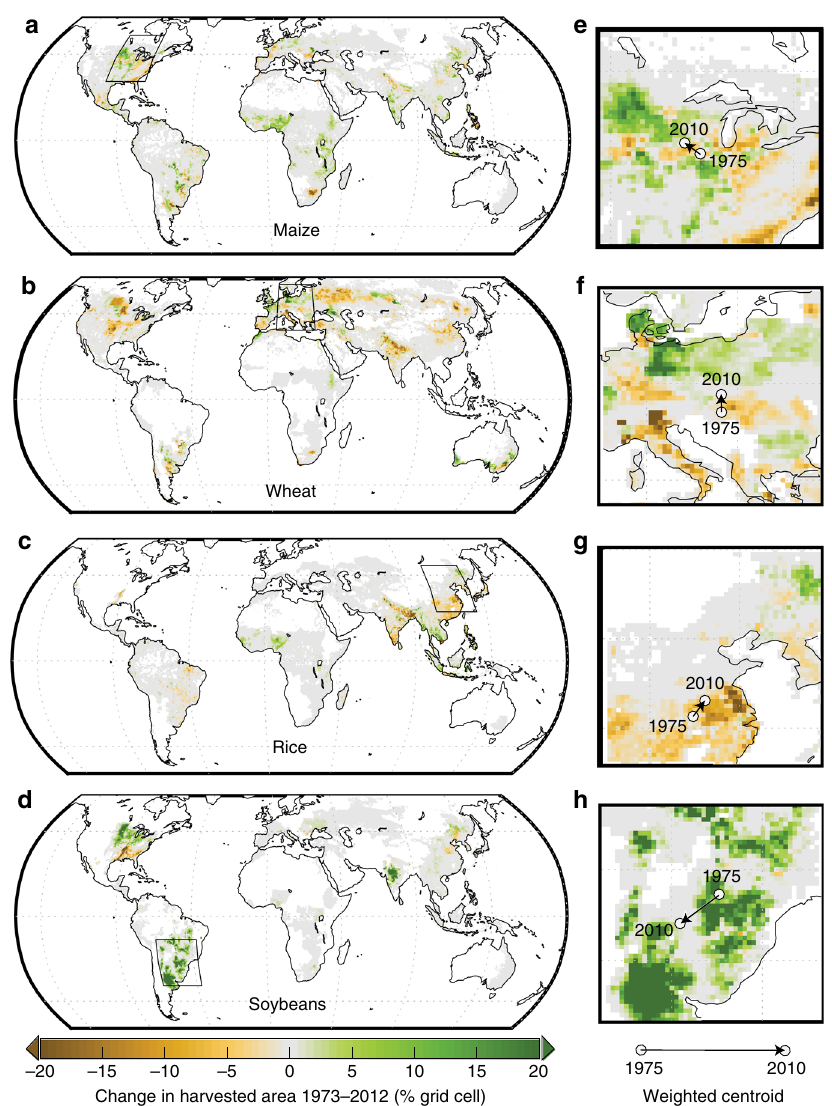
Fig. 3 Trends in rainfed harvested area between 1973 – 2012. Trends are calculated for maize ( a ), wheat ( b ), rice ( c ), and soybeans ( d ), using linear regression, and all values are displayed across the top 98% of harvested areas. Locations in brown/orange are experiencing decreases in rainfed harvested areas, locations in green are experiencing increases, and locations in gray are experiencing near-zero trends. Insets highlight areas that have experienced large changes and illustrate global trends, including a northwestern shift of maize ( e ) in the US, a northward shift of wheat in Europe ( f ), a northward shift in rice in China ( g ), and a general increase in soybean in Brazil and Argentina ( h ). White circles indicate the harvested-area weighted centroid of that region circa 1975 and the black arrowhead indicates the weighted centroid of that region circa